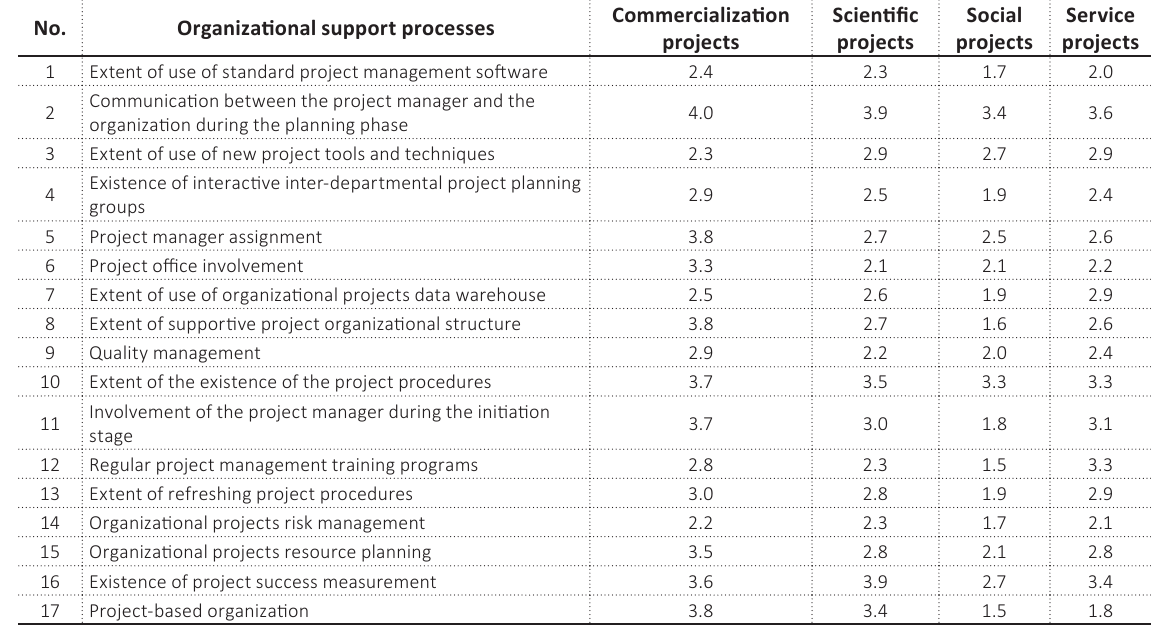
Table 2. Organizational support quality